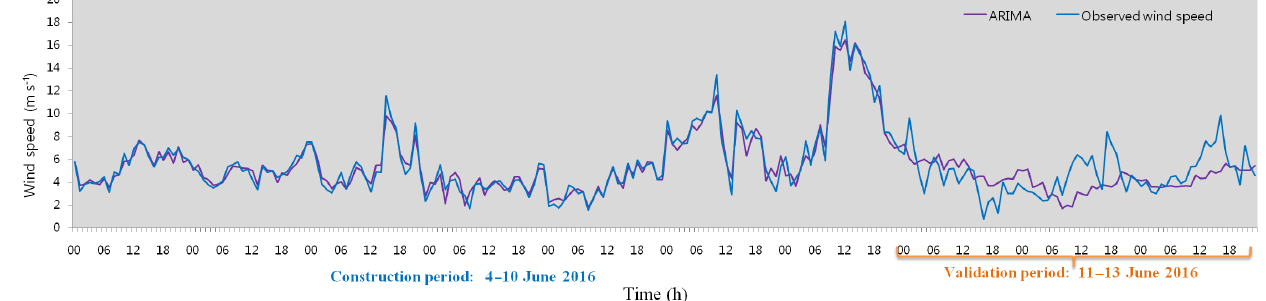
Figure 1. The contrast between the 0–72h ARIMA downscaling forecast and the observed wind speed on 10 June 2016.